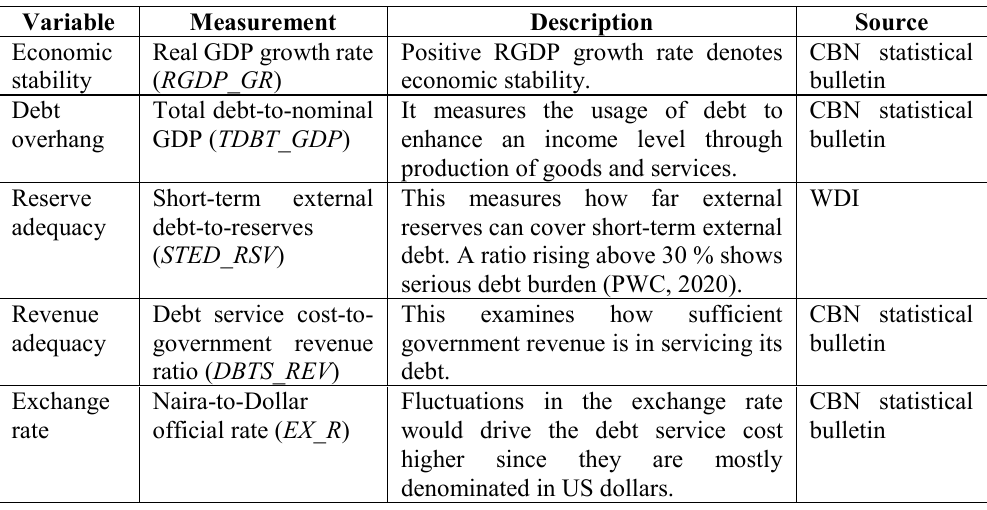
Table 1. Measurement, Description and Data Sources (Compiled by the